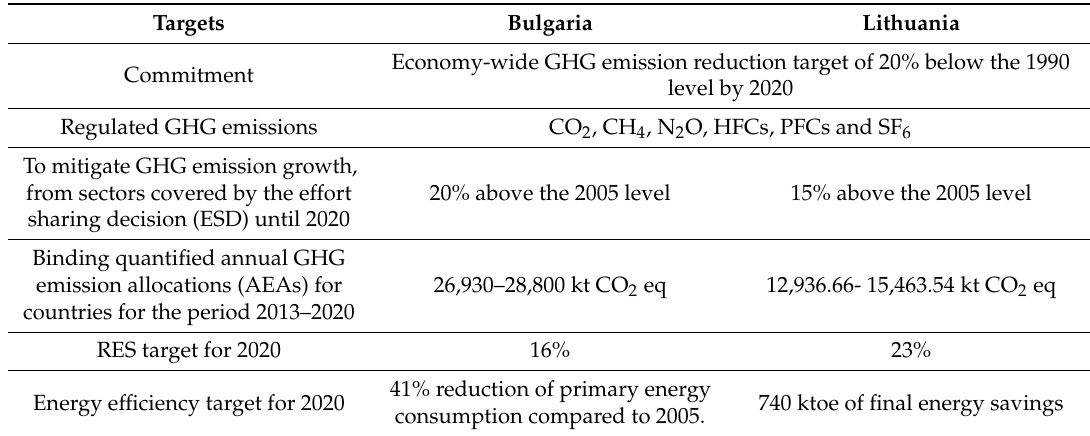
Table 4. Quantified economy-wide emission reduction targets for 2020 in Lithuania and Bulgaria. Source: [36,37].